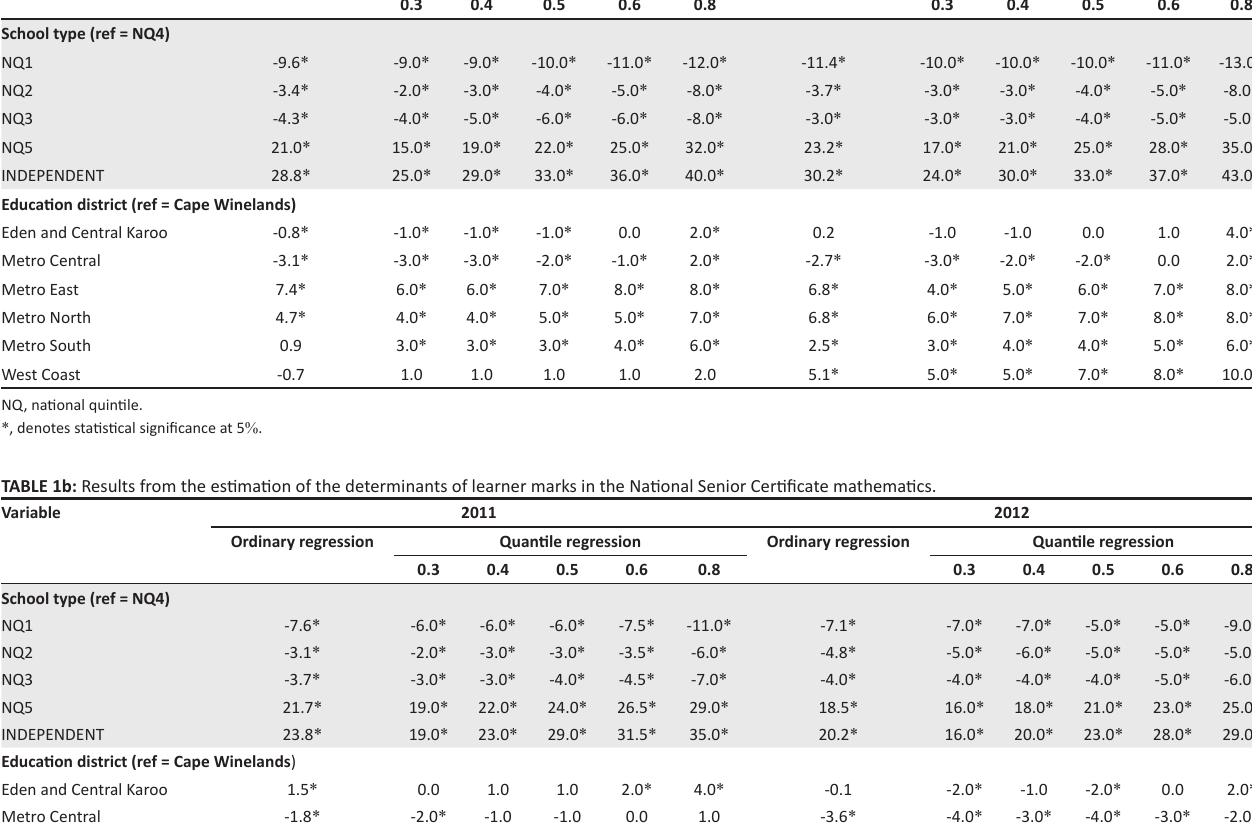
TABLE 1c: Results from the estimation of the determinants of learner marks in the National Senior Certificate mathematics. Variable